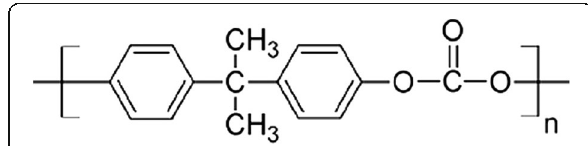
Fig. 1 Chemical structure (repeating unit) of Makrofol DE